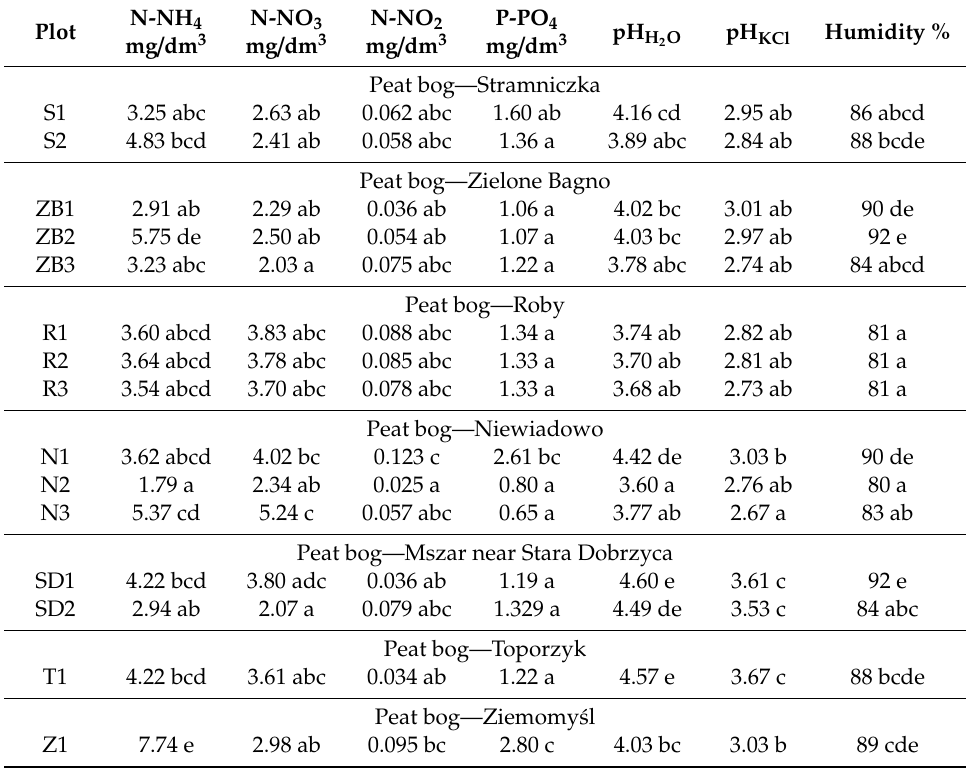
Table 3. Humidity and selected chemical properties of the top layer of peat soils. Plot